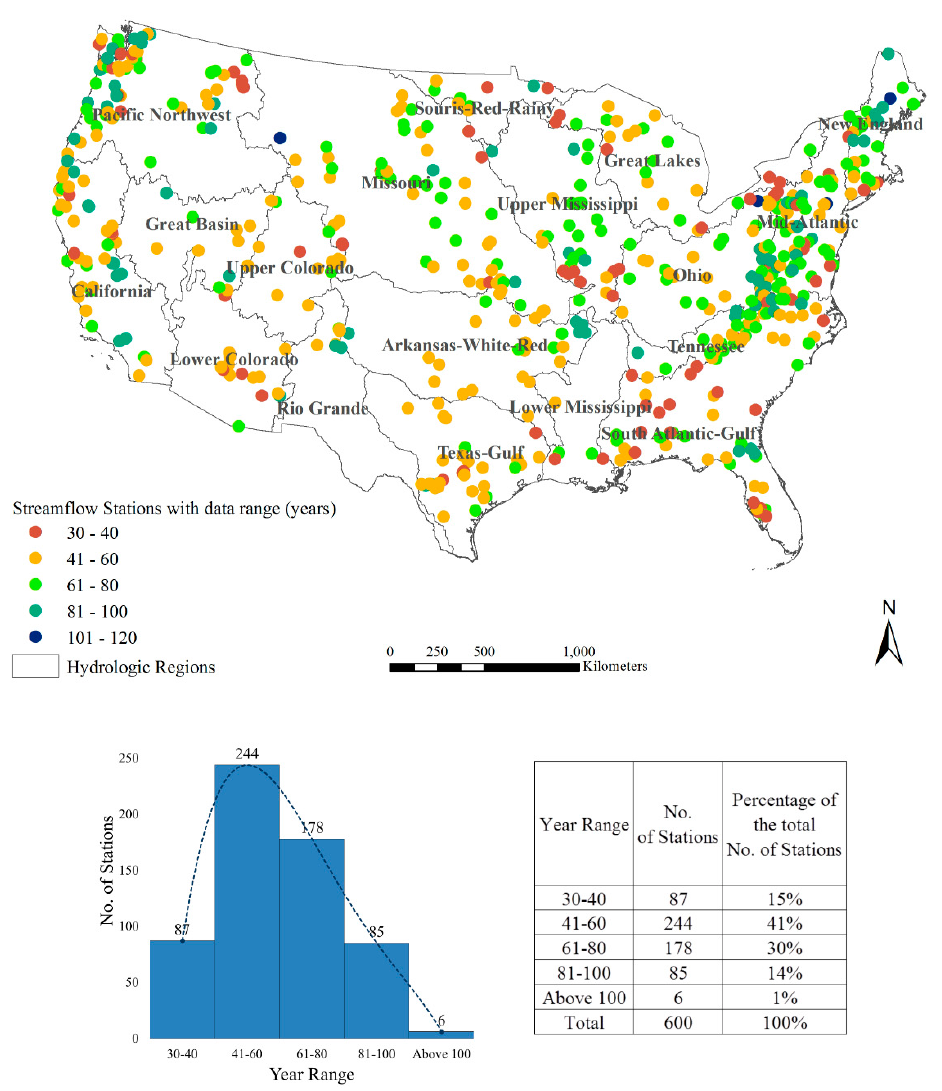
Figure 1. ( Top ) Map of the continental U.S. with 600 unimpaired streamflow stations across 18 hydrologic regions with available data range in years. ( Bottom left ) Distribution of the number of stations with varying ranges of data availability from 30 to 40 years, from 41 to 60 years, from 61 to 80 years, from 81 to 100 years and above 100 years. ( Bottom right ) Comparative percentages of the stations in each range of years.